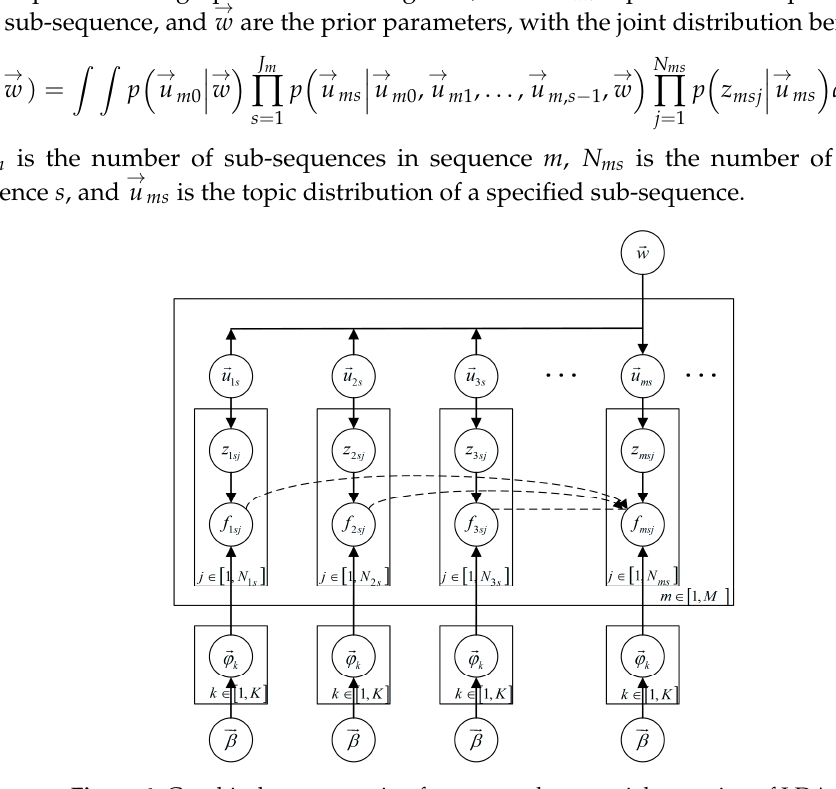
Figure 6. Graphical representation for a general sequential extension of LDA.